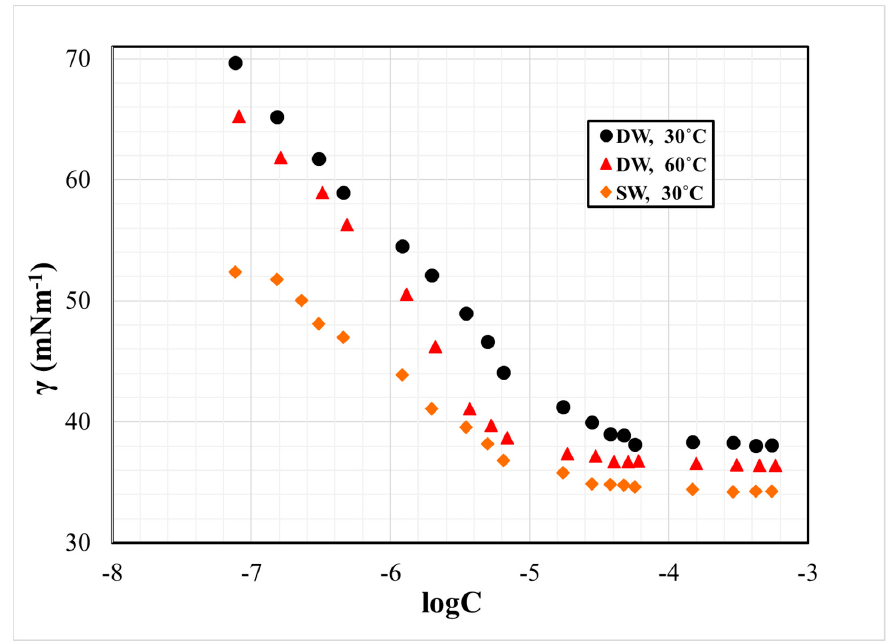
Figure 12. The surface tension of GS8 at different salinities and temperatures. Energies 2019 , 12 , x FOR PEER REVIEW